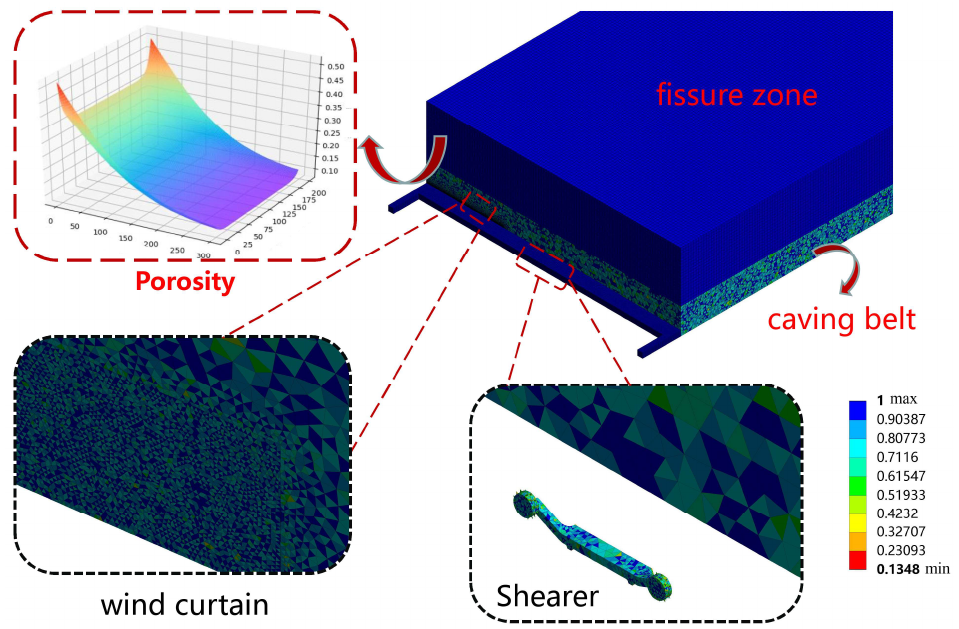
Figure 3. Model mesh quality.